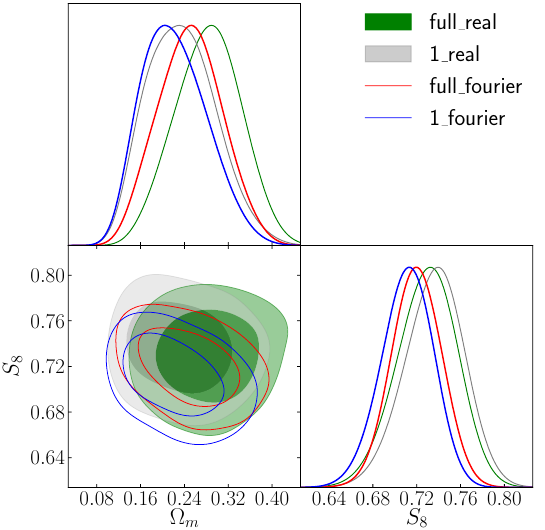
Figure 14. The same as in Figure 12 but here we compare the Figure 15. The same as in Figure 12 but the KL transform has contours obtained in the real-space analysis (solid lines and filled been calculated using a bad fit to the data, i.e. χ 2 ∼ 2 × χ 2 . bestfit contours) with the ones of the Fourier analysis assuming an (cid:96) - dependent KL-transform. ter space could in principle benefit from including addi- tional KL modes in order to break parameter degenera- cies. To explore this possibility, we have repeated our analysis for a “ w CDM” model, in which we parametrize the evolution of the equation of state of dark energy as w ( a ) = w 0 + (1 a ) w a (Chevallier and Polarski 2001; − Linder 2003), where a is the scale factor, and ( w 0 , w a ) are two new free parameters of the model 11 . The re- sults are shown in Figure 16 both for the Ω M - S 8 plane (top panel) and the w 0 - w a plane (bottom panel). As ex- pected, the parameter contours for Ω M - S 8 are broader than in the ΛCDM case. The corresponding parame- ter shift and degradation in the final error on S 8 when comparing the full and 1 cases are ∆ S 8 /σ 8 = 0 . 58, Table 4 ∆ σ ( S 8 ) /σ ( S 8 ) = 0 . 12. These are noticeably larger than We show the size of the data vector along with the Figure of in the ΛCDM case, reflecting the fact that additional in- Merit (FoM) for each case considered here. The first column indicates the KL-compression used. The second column shows the formation is encoded in the remaining KL modes. This size of the data vector for each method, where s (cid:96)θ = 5 in Fourier is more evident in the w 0 - w a plane, where the uncer- space (5 (cid:96) bandpowers) and s (cid:96)θ = 10 in Real space (6 angles θ for tainties on both parameters degrade noticeably if only ξ + and 4 for ξ − ). The other columns show the FoM for each case, a single mode is used. However, we can see that, by calculated as the Area − 1 of the 1 σ contour in Ω m - S 8 . “Fourier including both the first and second KL modes and con- SI” refers to the analysis in Fourier Space with (cid:96) -independent KL-transform, “Fourier SD” refers to the (cid:96) -dependent sidering their cross-correlation (dashed violet contours), KL-transform, while “Real” shows the KL-transformed results in we can recover the same constraints found when using real space. the full data vector (which is also true for the Ω M - S 8 plane). Therefore, the compression efficiency degrades in this case from a factor 30 to a factor 10, which is ∼ ∼ still significant. This result should come as no surprise, since figures 9 and 11 show that, even if the S/N ratio is dominated by the first KL mode, some information can still be ex- tracted from the second one. In the context of the w